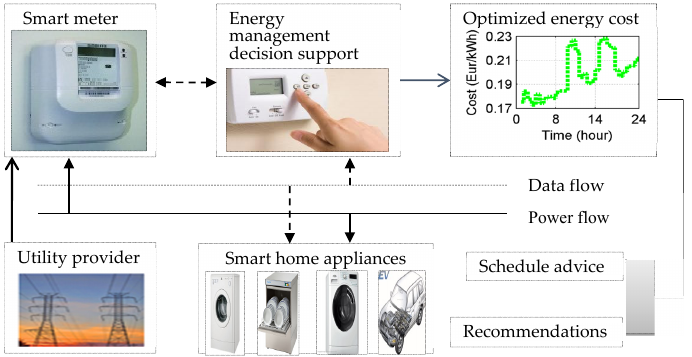
Figure 1. Block diagram of Residential energy management system